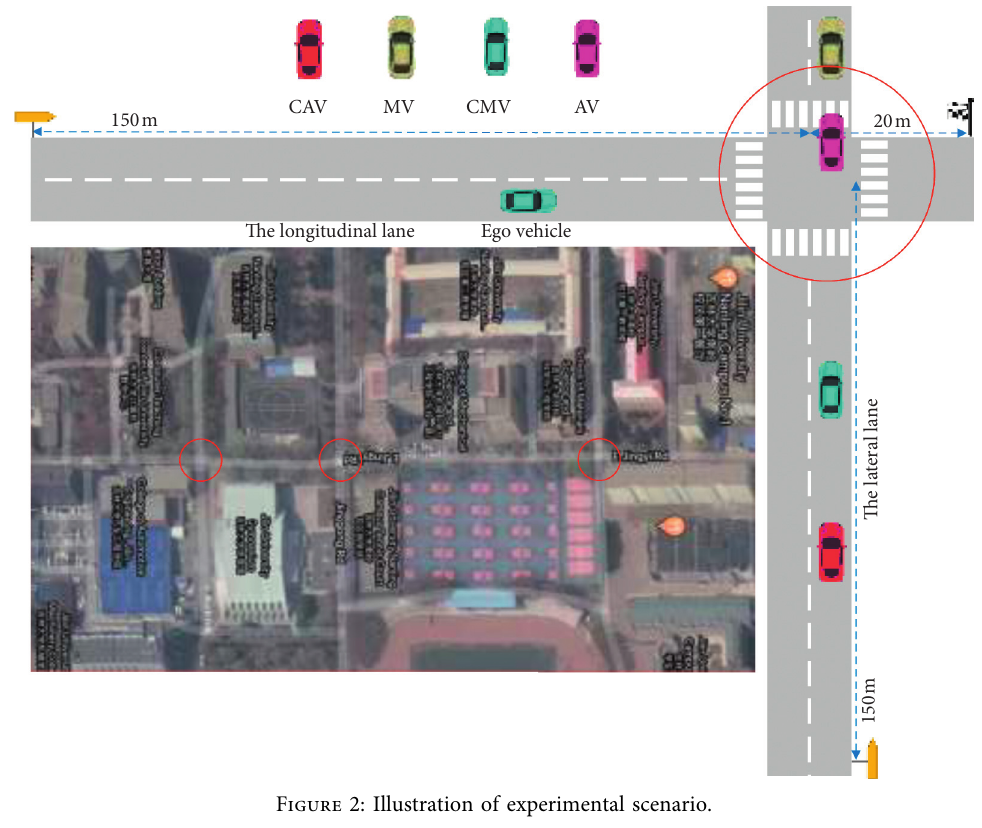
Figure 2: Illustration of experimental